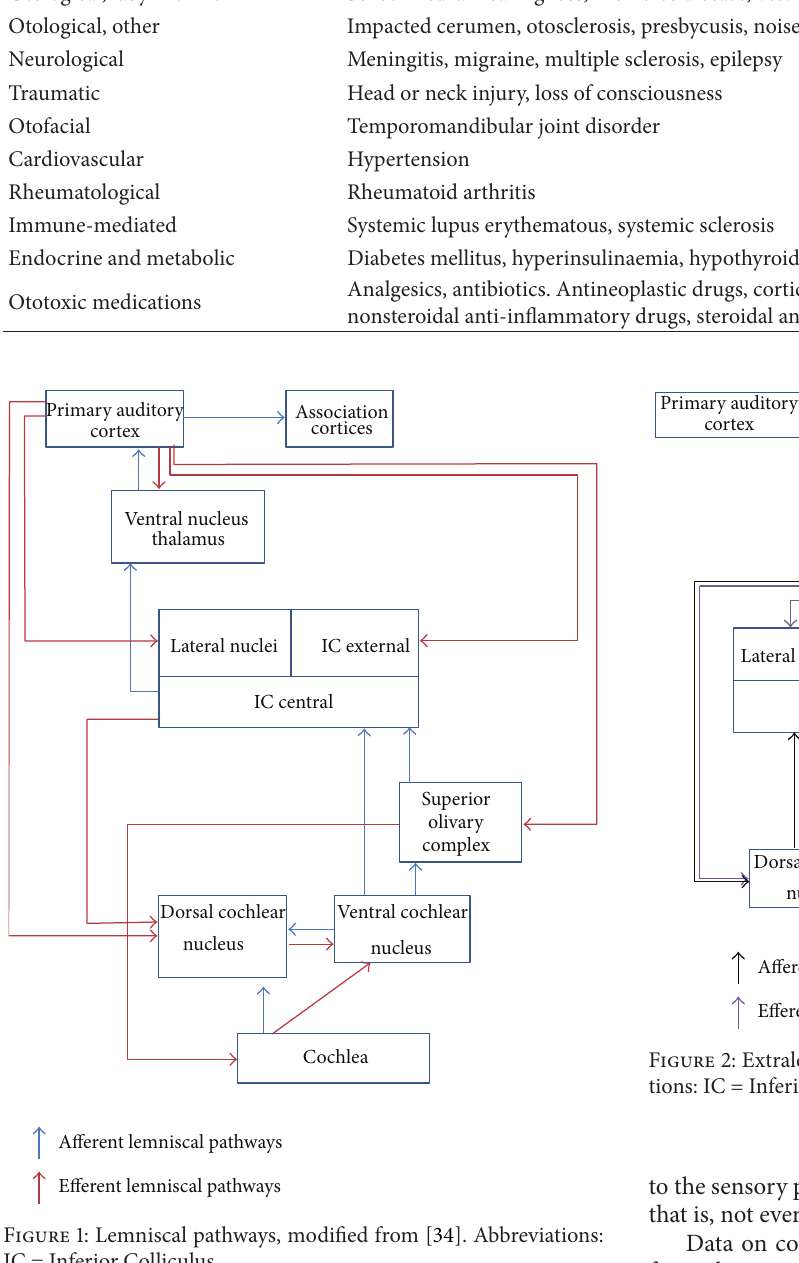
Figure 1: Lemniscal pathways, modified from [34]. Abbreviations: IC = Inferior Colliculus.